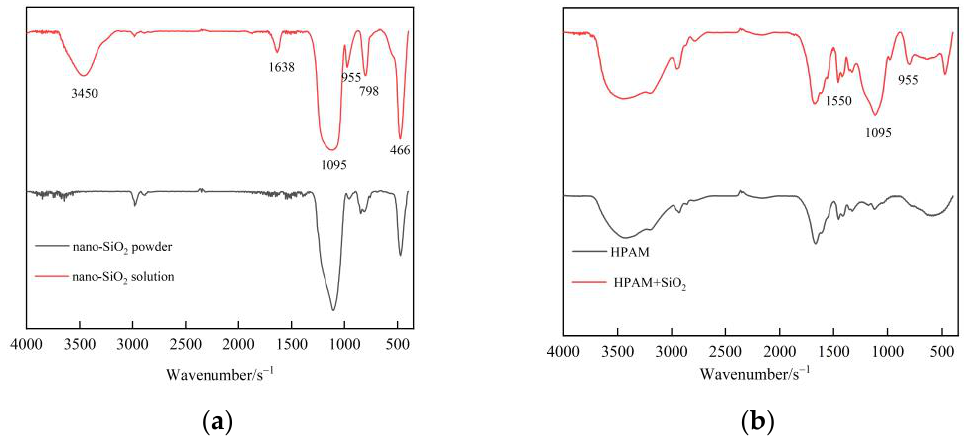
Figure 3. FTIR spectra of nano-SiO 2 and polymer: ( a ) Nano-SiO 2 ; ( b ) Nano-SiO 2 and polymer.